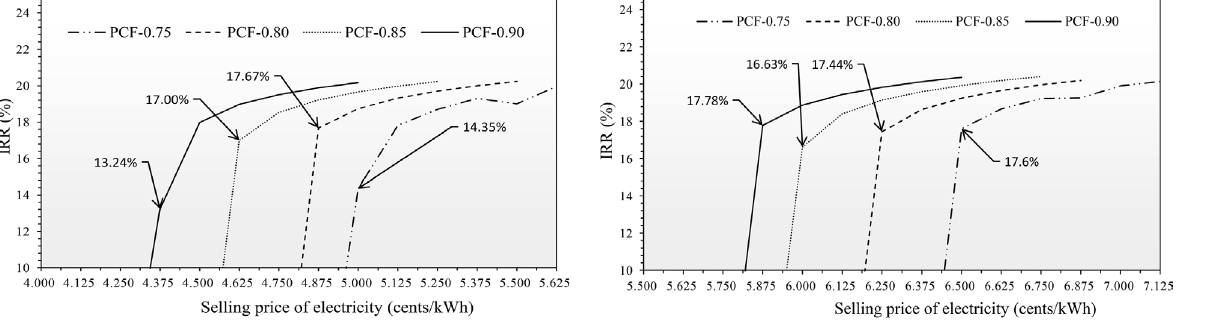
Figure 6. Variation of IRR with selling price of electricity con - sidering high O&M costs-14.5$/MWh and fuel costs-11.2$/ MWh, discount rate-10% and PCFs-75, 80, 85, and 90% (Case 5 to 8).